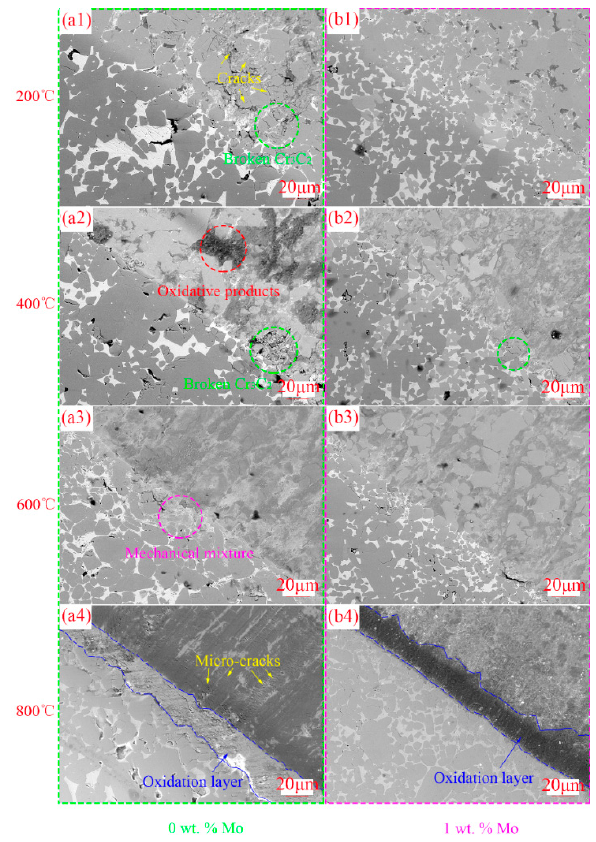
Figure 3. SEM and 3D laser scanning morphologies of the wear surface for the specimens without Mo and with 1.0 wt. % Mo addition at different temperature: ( a1 – b4 ) the specimen without Mo, ( c1 – d4 ) the specimen with 1.0 wt. % Mo addition.